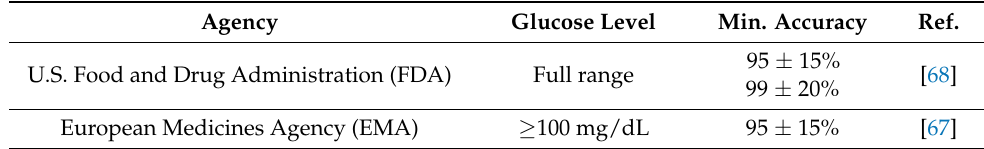
Table 4. Approval Criteria for Self-monitoring Blood Glucose Devices.